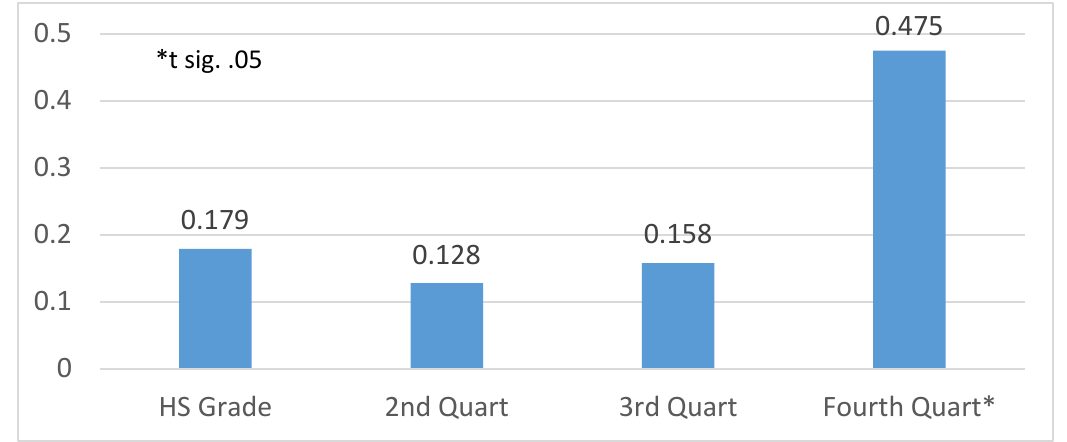
FIGURE 13. BETAS OF POST-TEST QUARTILE CONTRIBUTION TO ACADEMIC ACHIEVEMENT